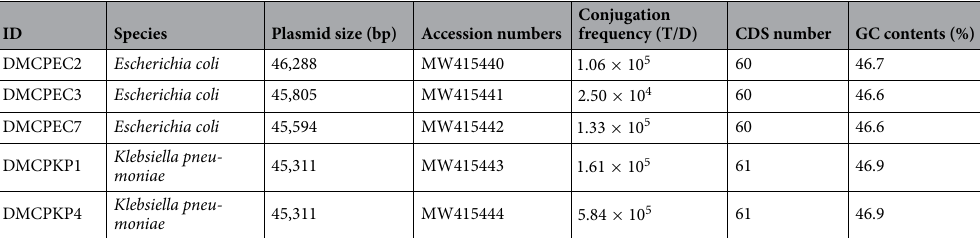
Table 2. Genomic information of plasmids harboring bla NDM-5 gene in Carbapenemase-producing Enterobacterales isolates in this study. Plasmid DNAs were isolated with the QIAGEN Plasmid Mini Kit (QIAGEN, Germany) and sequenced with the Illumina MiSeq sequencing platform.